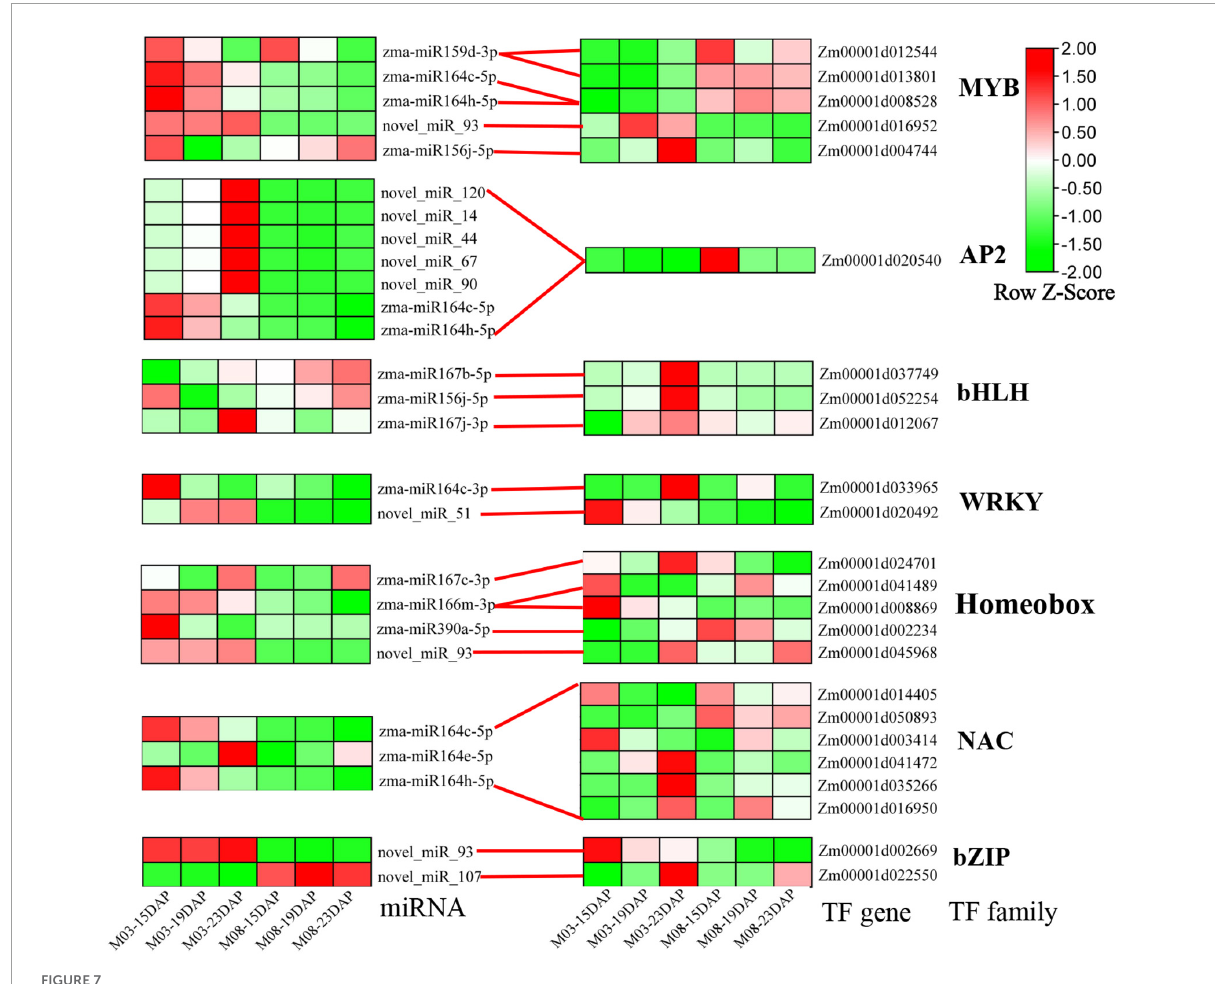
FIGURE7 Heatmap of differentially expressed TFs and their corresponding